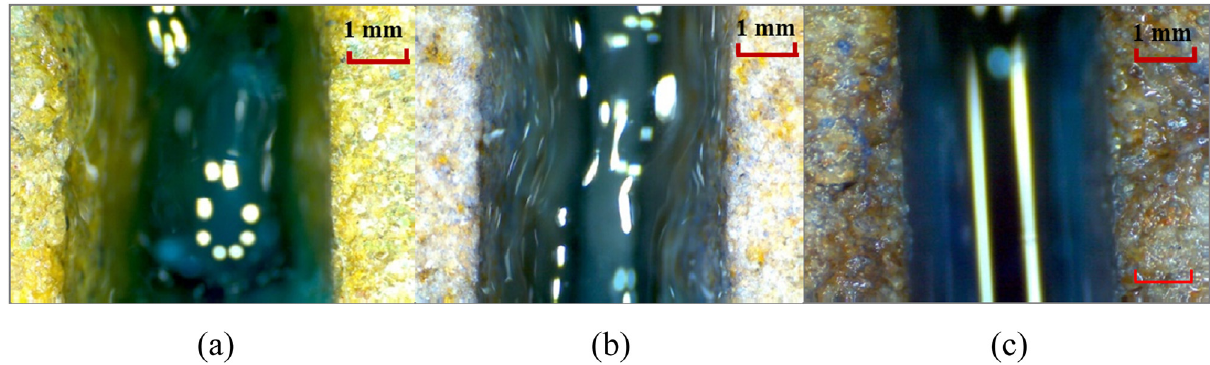
Figure 7: Gelling e ff ect of polymer gel at di ff erent Cr 3 + leak o ff degrees. ( a ) slight leak o ff , ( b ) moderate leak o ff , ( c ) gross leak o ff .